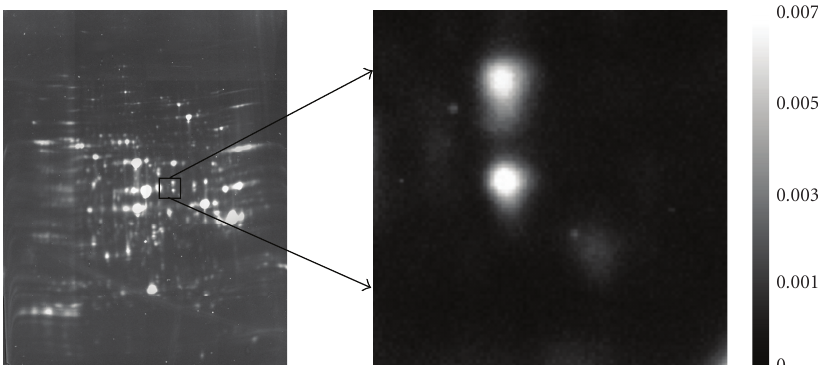
Figure 1: 2-DE Image : Example of a two-dimensional gel electrophoresis image associated with a particular cyanine dye and light source. Various sources of noise can exist in this image, including general background noise, dust, streaks, and so forth. Further, issues such as low-lying spots and overlapping spots can make spot detection and quantification di ffi cult.